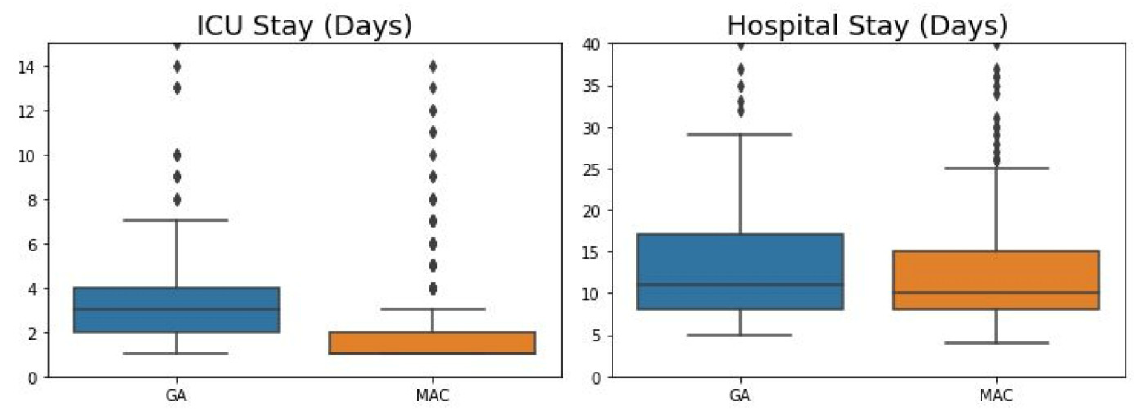
Figure 3. Comparison of hospital stay and length of stay in the intensive care unit in the GA and MAC groups. GA, general anesthesia; MAC, monitored anesthesia care; ICU, intensive care unit.